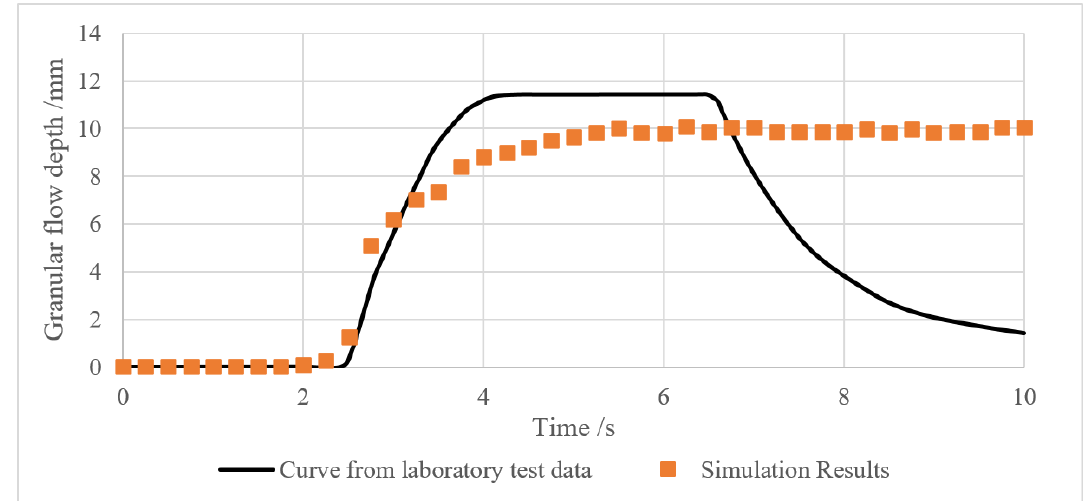
Figure 5. Comparison of laboratory data and simulation results (the continuous regression curve is obtained from experimental data in Hauksson et al. (2007), and the orange square dots are the simulation data).